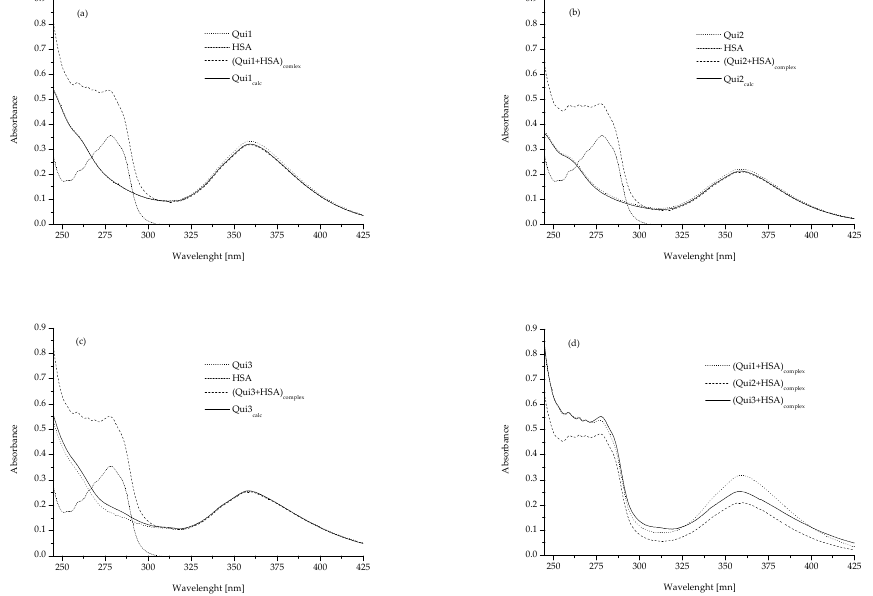
Figure 2. TheabsorptionspectraofQui1,HSA,(Qui1+HSA) complex andQui1 calc =(Qui1+HSA) complex − HSA Figure 2. The absorption spectra of Qui1, HSA, (Qui1 + HSA) complex and Qui1 calc = (Qui1 + HSA) com- ( a );Qui2,HSA,(Qui2+HSA) complex andQui2 calc =(Qui2+HSA) complex − HSA( b );Qui3,HSA,(Qui3+HSA) complex plex —HSA ( a ); Qui2, HSA, (Qui2 + HSA) complex and Qui2 calc = (Qui2 + HSA) complex —HSA ( b ); Qui3, andQui3 calc =(Qui3+HSA) complex − HSA( c );(Qui1+HSA) complex ,(Qui2+HSA) complex and(Qui3+HSA) complex HSA, (Qui3 + HSA) complex and Qui3 calc = (Qui3 + HSA) complex —HSA ( c ); (Qui1 + HSA) complex , (Qui2 + ( d ); Qui1, Qui2 and Qui3 concentration 5 × 10 − 5 M, HSA concentration 2.5 × 10 − 5 M; ligand: HSA molar ratio (in(Qui-HSA) complex